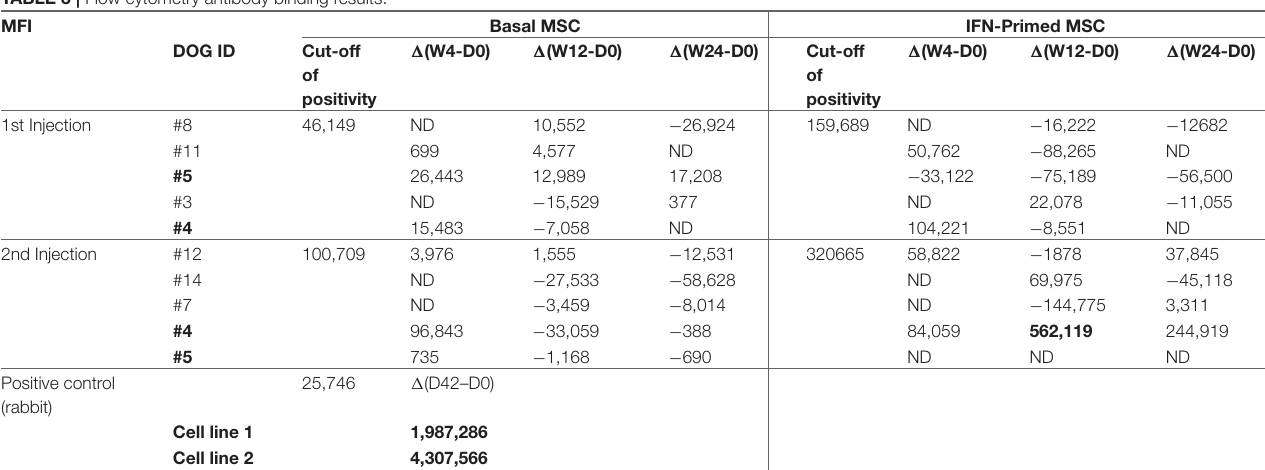
TABLE 3 | Flow cytometry antibody binding results. MFI Basal